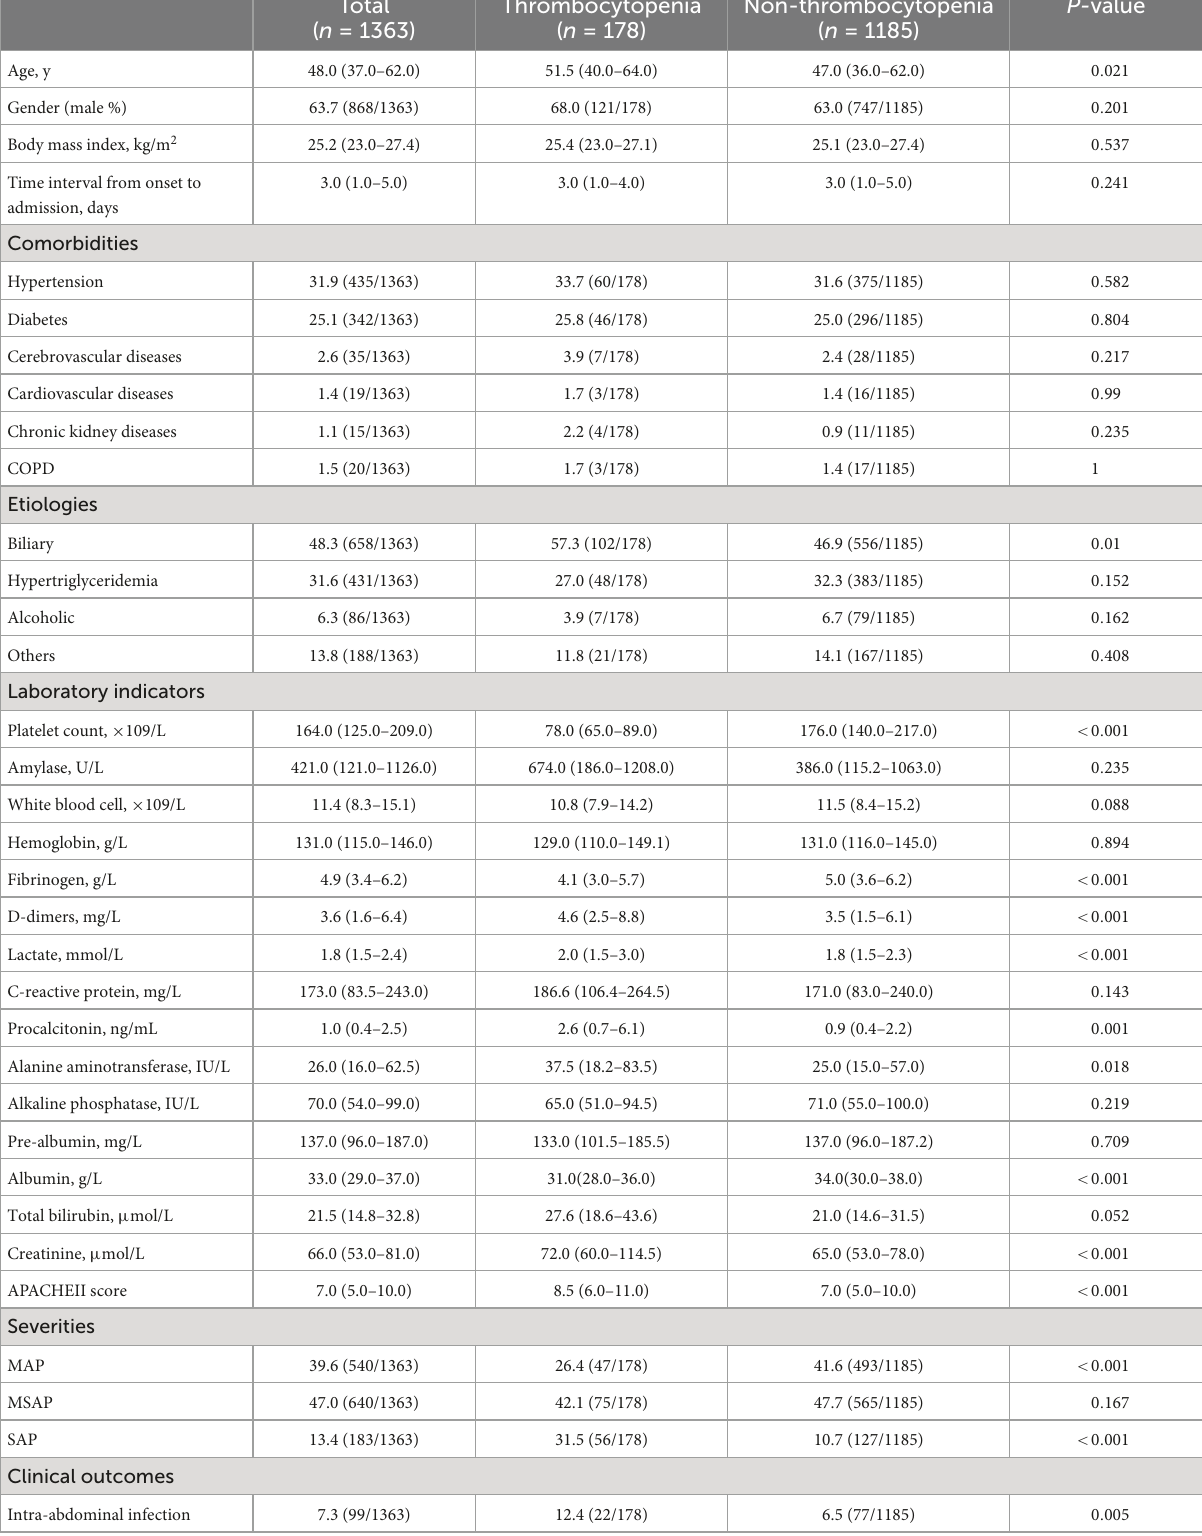
TABLE 1 Baseline characteristics of acute pancreatitis patients with thrombocytopenia and without